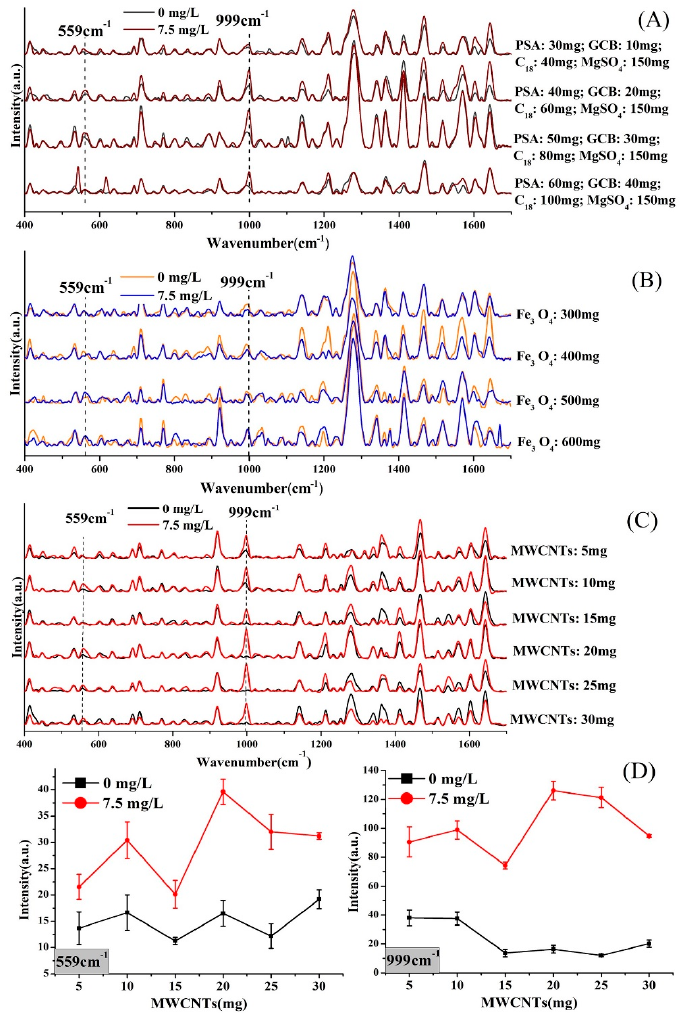
Figure 5. The choice of purification conditions. ( A ) SERS of extracts purified by primary secondary amine (PSA), C 18 , graphitized carbon black (GCB) and anhydrous MgSO 4 ; ( B ) SERS of extracts purified by Fe 3 O 4 with a particle size of 100 nm; ( C ) SERS of extracts purified by multi-walled carbon nanotubes (MWCNTs); ( D ) peak intensity after purification by different amount of MWCNTs at 999 cm − 1 and 559 cm − 1 .